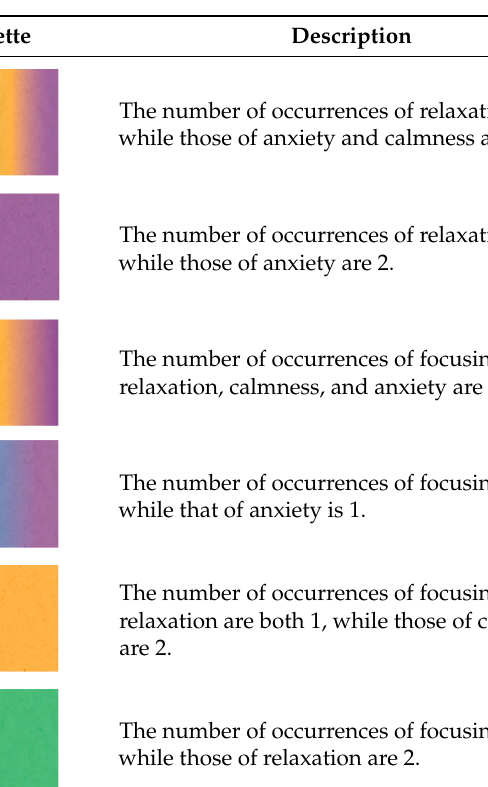
Table 2. Descriptions of emotions and corresponding color palettes.